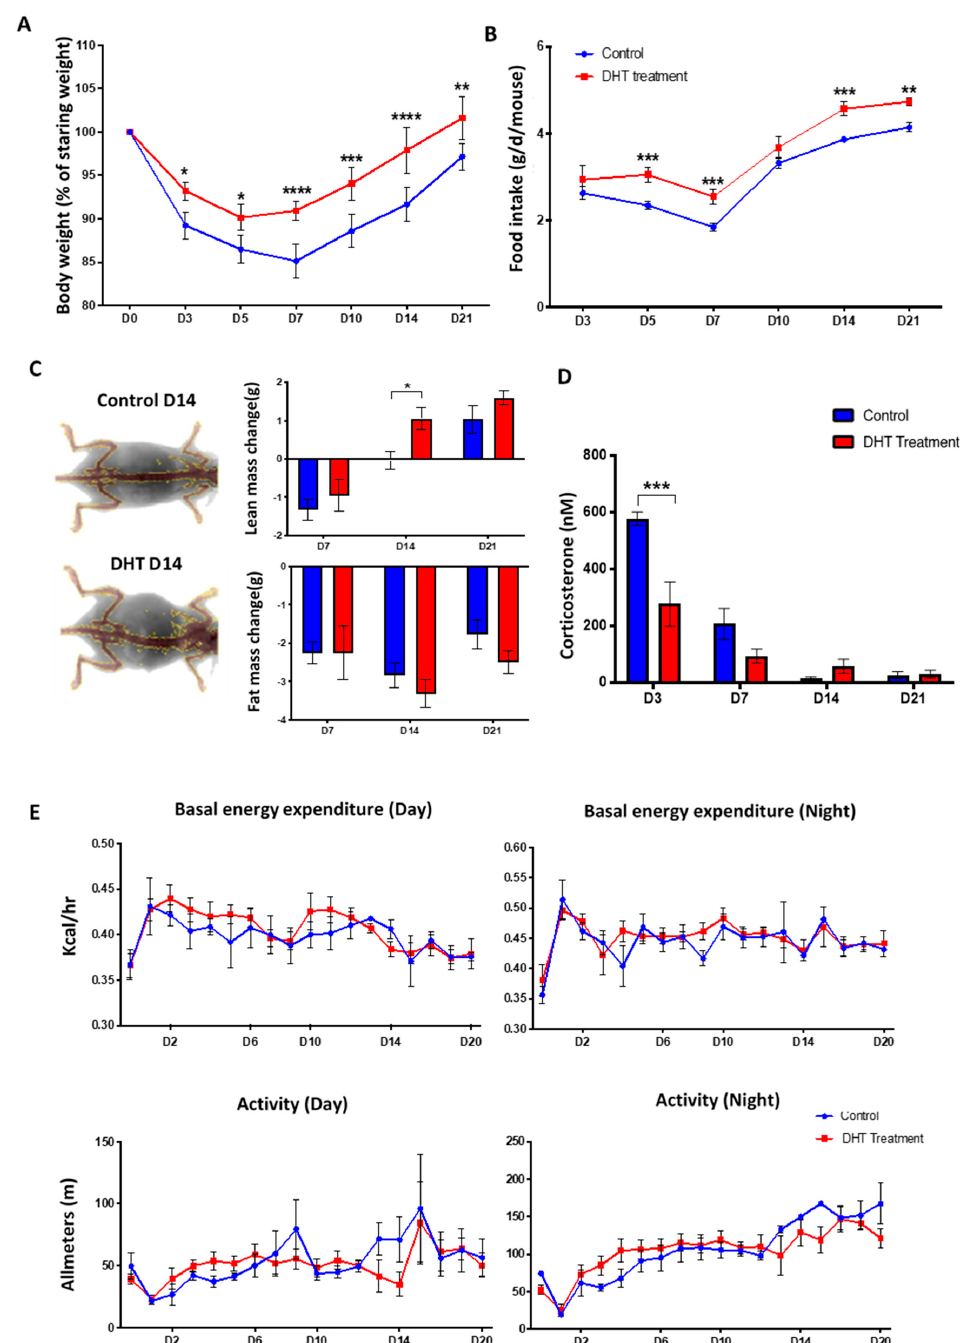
Figure 2. General catabolic response to major burn injury.( A ) Bodyweight (% of starting weight post-burn injury) showing reduced weight loss in DHT treatment group. ( B ) Food intake in control and DHT treatment mice throughout the wound healing process. ( C ) Lean and fat mass change from baseline taken prior to burn injury, as assessed by dual-energy X-ray absorptiometry (DEXA), showing increased lean mass weight at day 7 after DHT treatment. ( D ) Significant lower serum corticosterone concentration was observed in the DHT treatment group on day 3 post-burn when compared to control. ( E ) No significant differences were observed from both basal energy expenditure and activity of the mice recorded during the day and night from metabolic cage throughout the wound healing process, control and DHT treatment. n = 6 per time point, * p < 0.05, ** p < 0.01, *** p < 0.001, **** p < 0.0001. Statistical significance was analysed using repeat measurement on two-way ANOVA ( A , B , E ) and two-way ANOVA ( C , D